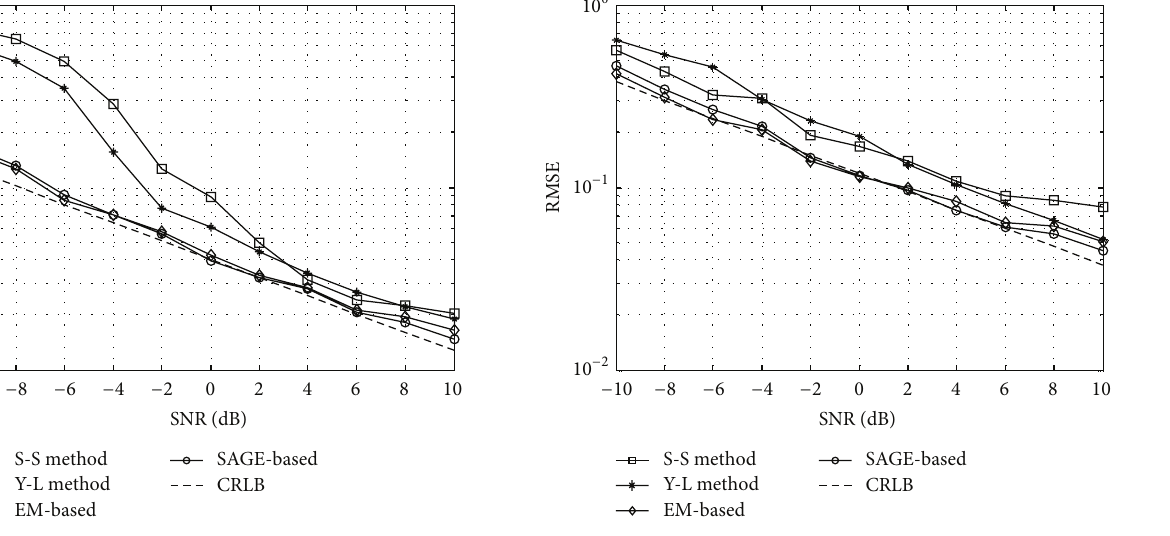
Figure 1: RMSE of DOA estimates of different methods against SNR.